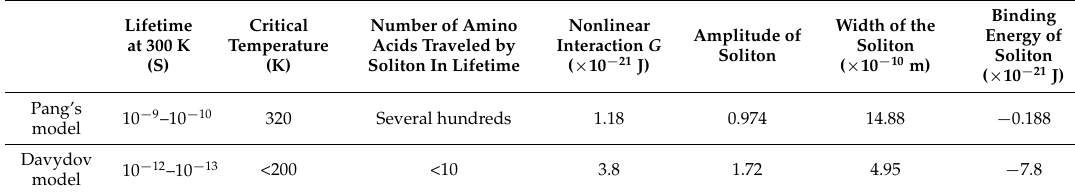
Table 1. Comparison of soliton features in Pang’s model and the Davydov